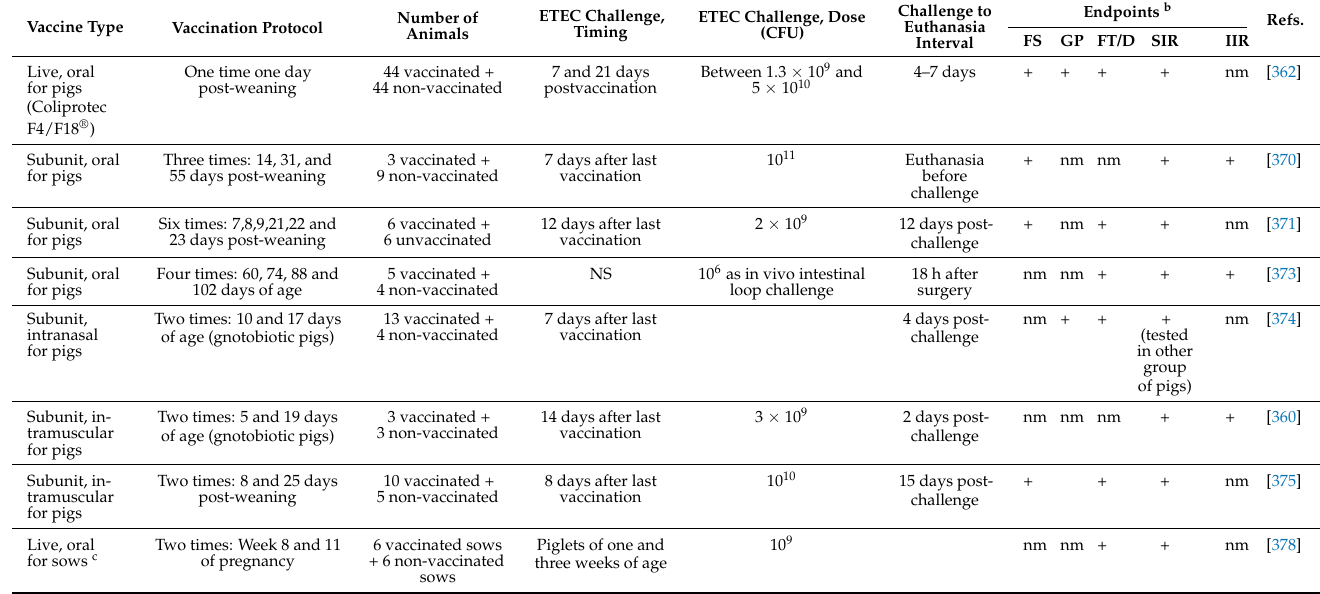
a Table limited to challenge studies involving pigs. +: A positive effect; nm: not measured. b FS: faecal shedding of challenge strain; GP: growth performance; FT/D: faecal traits/reduction in diarrhoea episodes; SIR: serum immune response; IIR: intestinal immune. c Results given for pigs (not